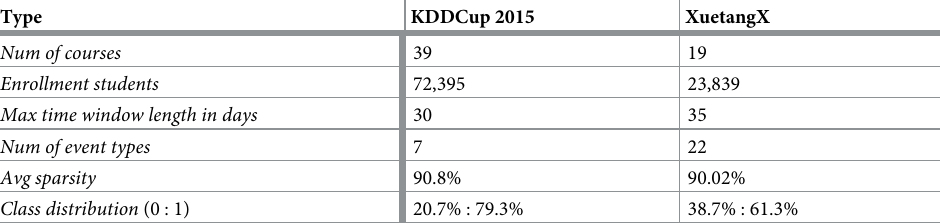
Table 1. Datasets characteristics of KDDCup 2015 and